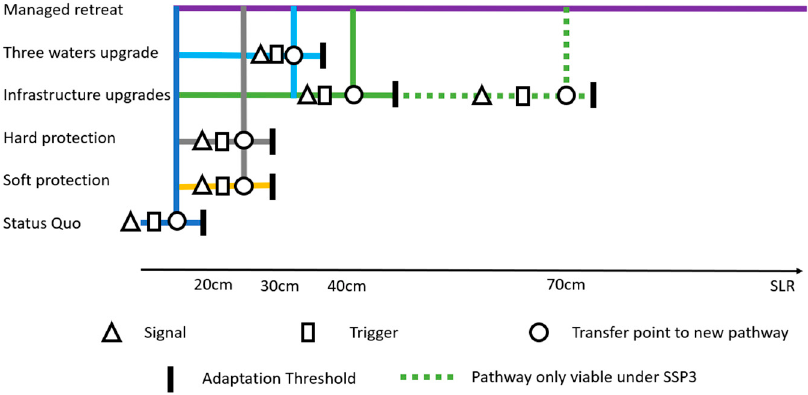
Figure 5. Adaptation pathway map representing the range of viable simulated pathways (i.e., that avoid adaptation thresholds) across all six SSP/RCP scenarios, based on the approximate RSLR value at which pathway changes are instigated. Unlike Figure 2, the X axis shows the timing of pathway changes based on RSLR, which is the main instigator of pathway change and which varies across scenarios. Each coloured line represents a different adaptive action.